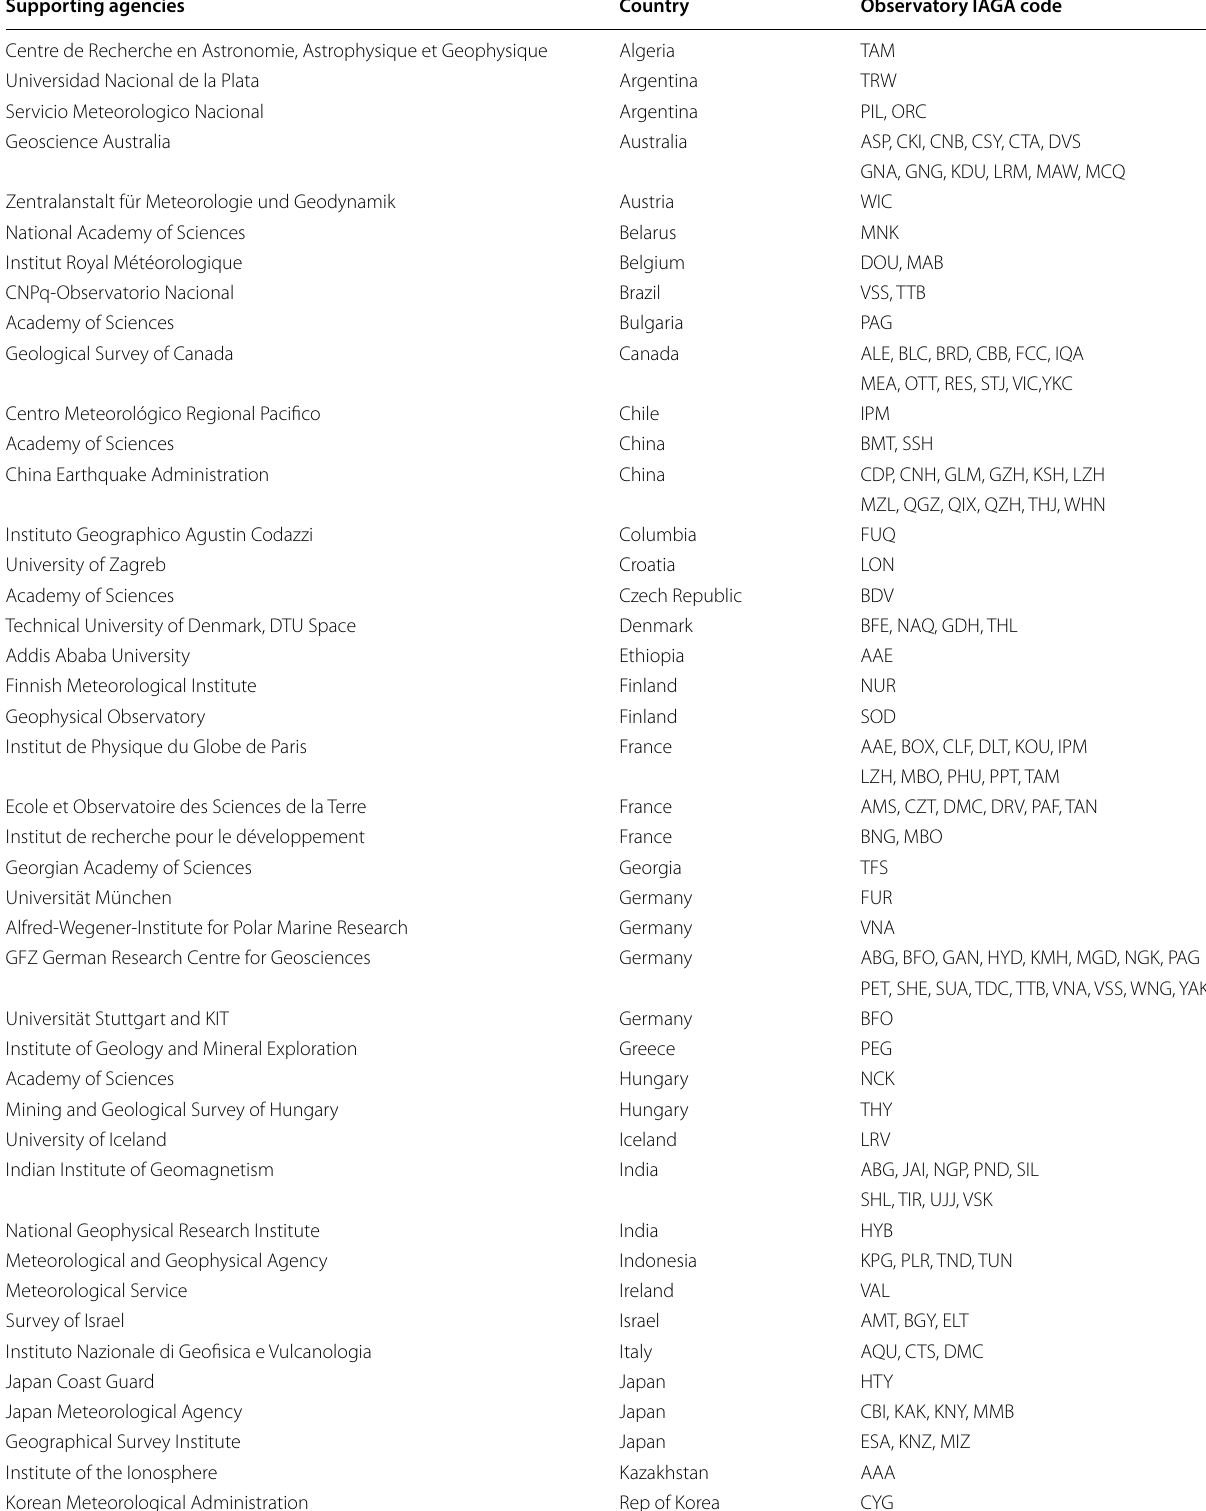
Table 3 Magnetic observatories contributing data used in the construction of IGRF‑13 Supporting